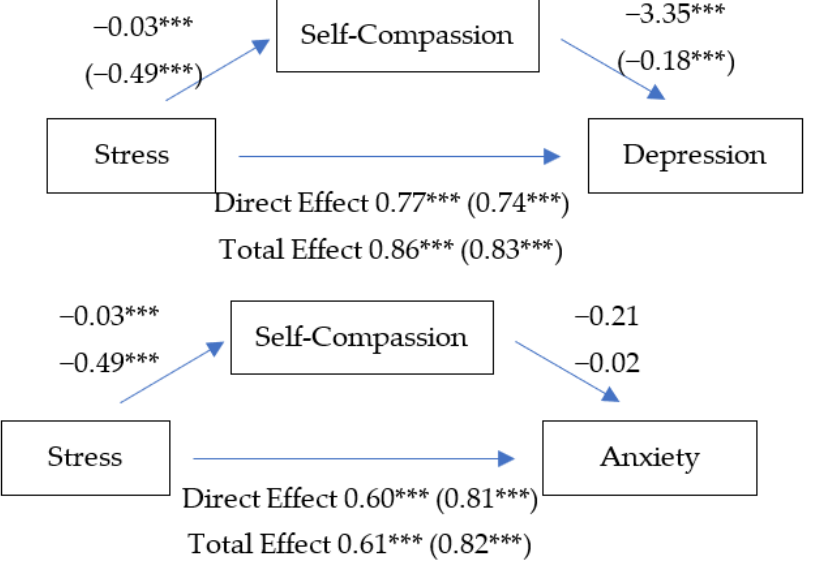
Figure 1. Parallel Mediation Model: Self-Compassion mediated the Stress–Depression Pathway but did not mediate the Stress–Anxiety Pathway . *** p < 0.001 (standardised